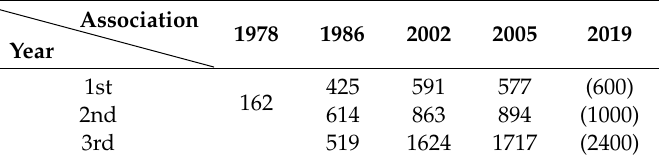
Table 1. Transition of demographics in the Riverside